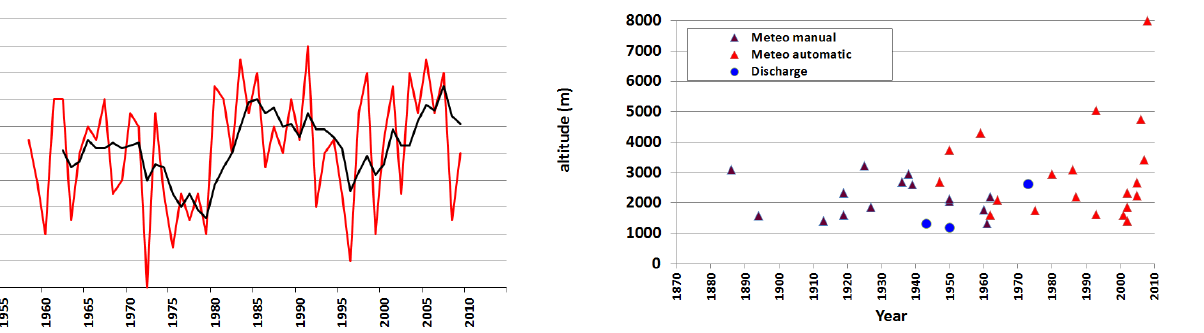
Fig. 1. Changes in the percentage of dry days per year over the last 50yr (red line) with 5-yr moving average (black line) for the Piemonte region (data from APRA Piemonte). Although not in- cluded in the graph, data for the year 2011 reached the higest values over the last 50yr.